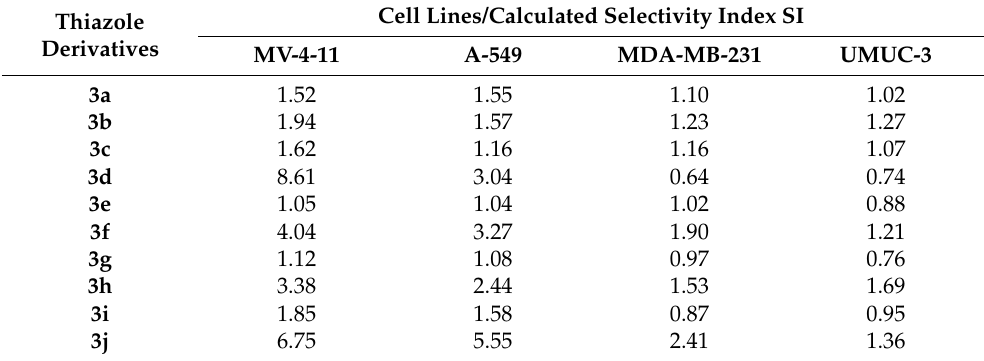
Table 4. The selectivity index (SI) of tested compounds. The SI index = IC 50 for normal cell line (Balb/3T3)/IC 50 for appropriate cancer cell